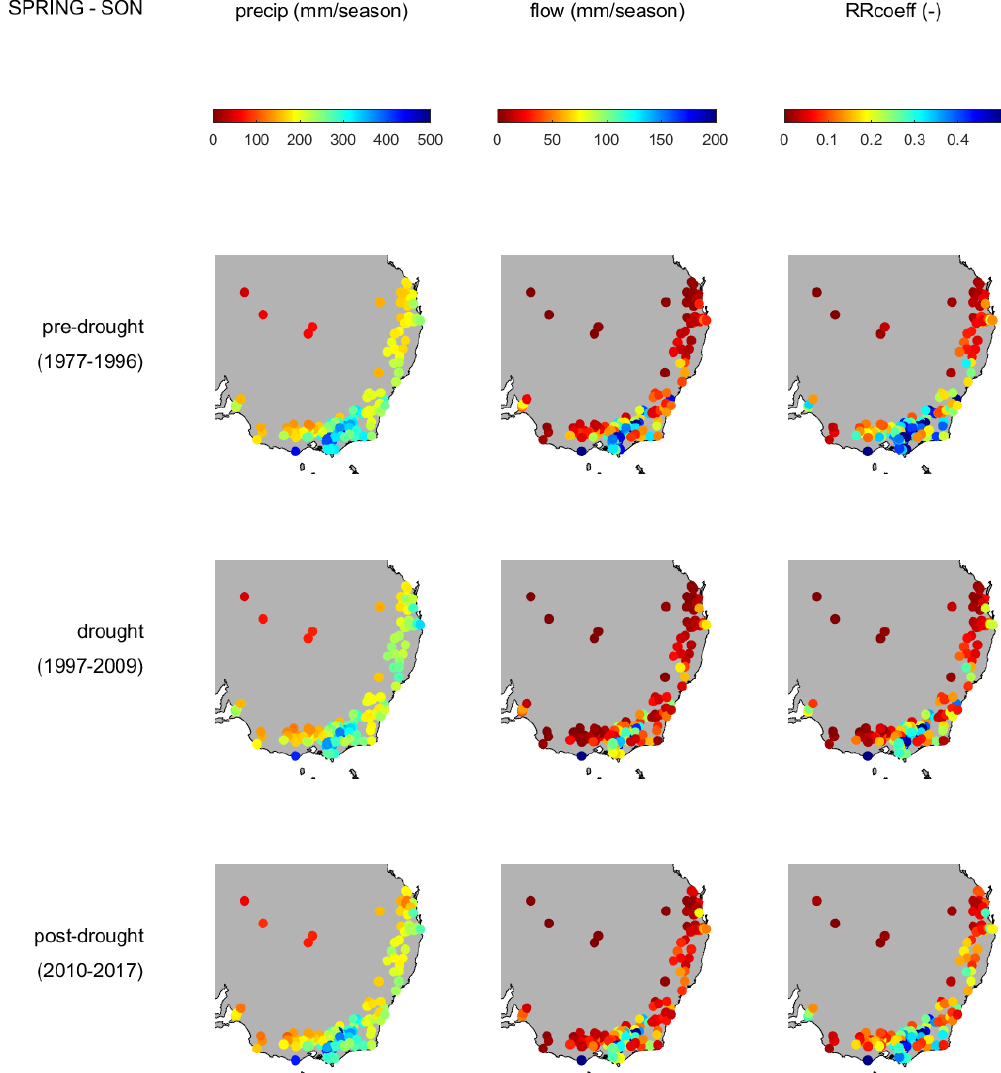
Figure B5. Same as Fig. B2 but for spring (September, October, and